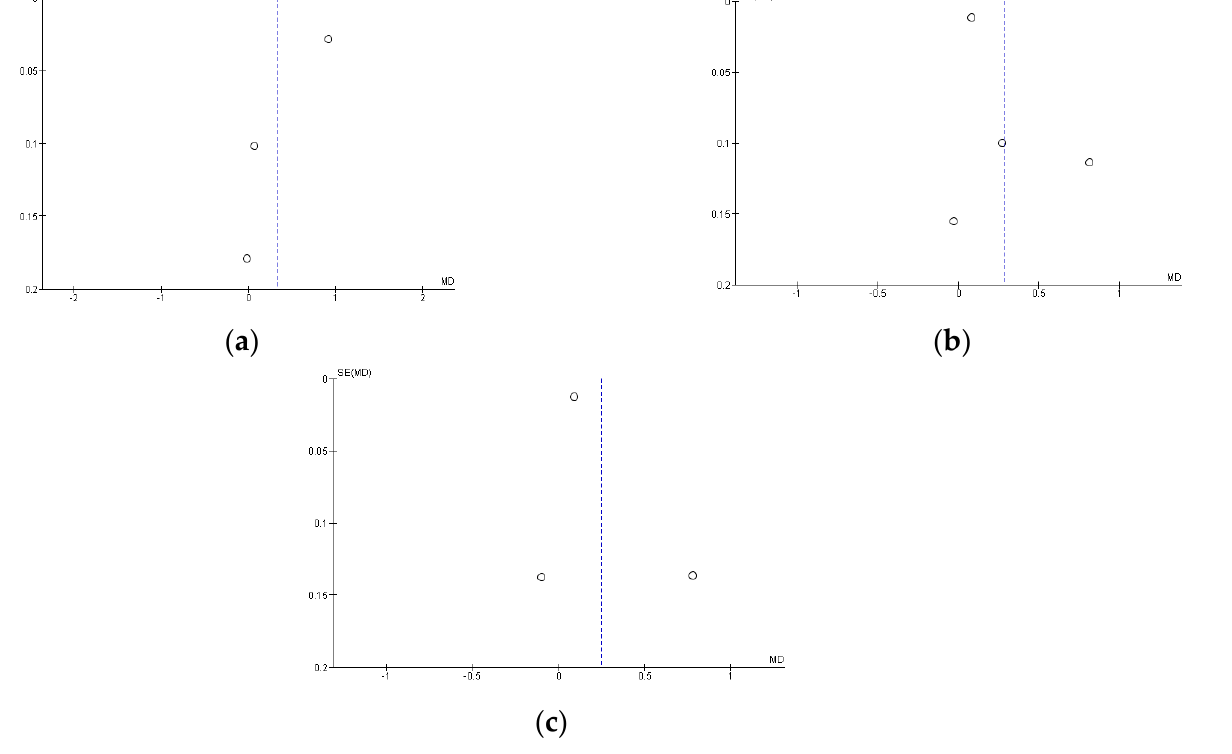
Figure 7. Risk assessment of publication bias using plot funnels with LAZ ( a ), WAZ ( b ), and WHZ ( c ) indicators.